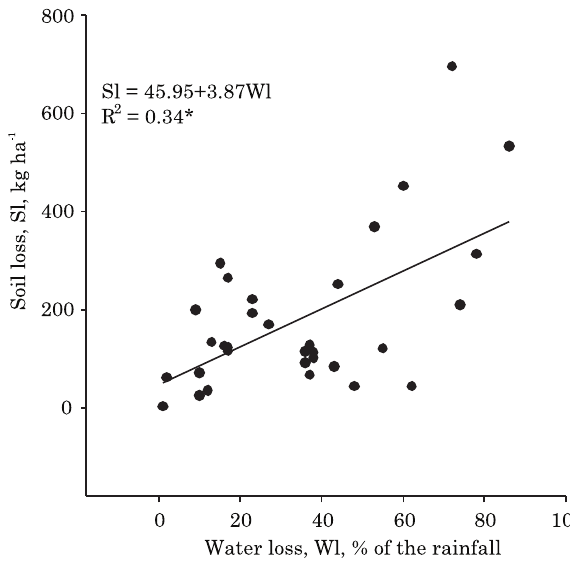
Figure 4. Relationship between soil loss (Sl) and water loss (Wl), considering all treatments with soil cultivation and rainfall tests